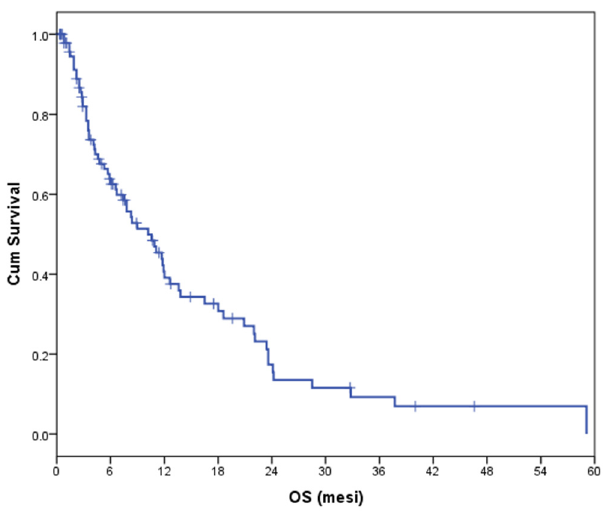
Figure 2. Overall survival of the study population (median OS = 10.2 months).